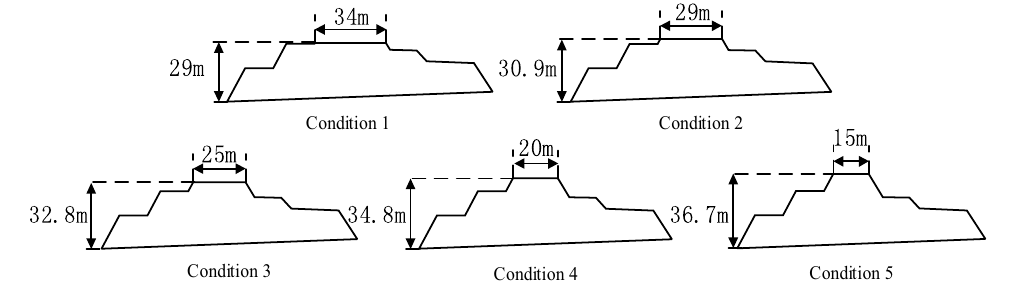
Fig. 12 Cross-sections of the optimal coal pillar shapes under five working conditions Table 5 Calculation of coal pillar volume Working condition